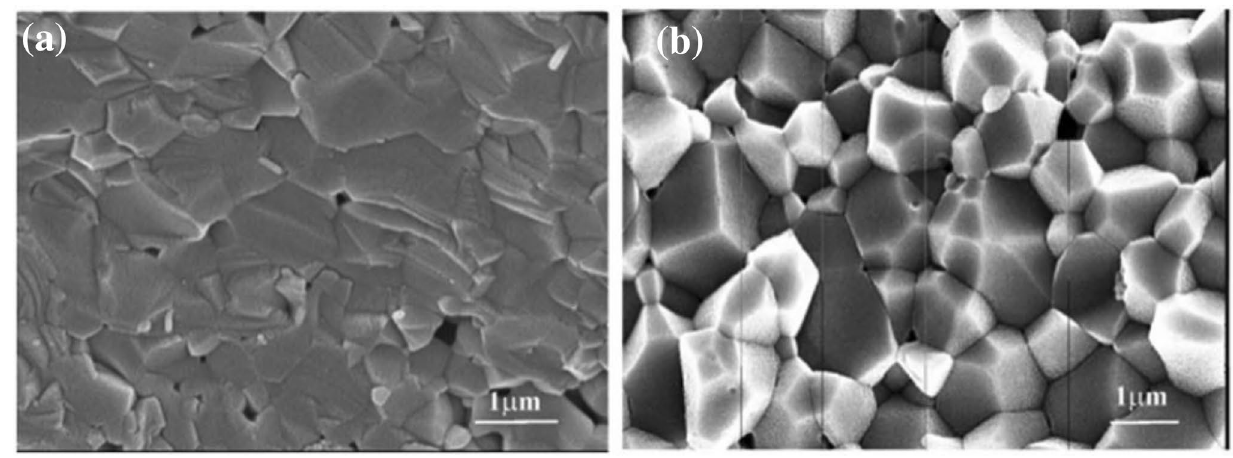
Fig. 9 Cross section of the SDC for the corrosion test in Li-K carbonate at 700 °C in an air atmosphere for 10 days: a before the corrosion test; b after the corrosion test. Reproduced from ref.